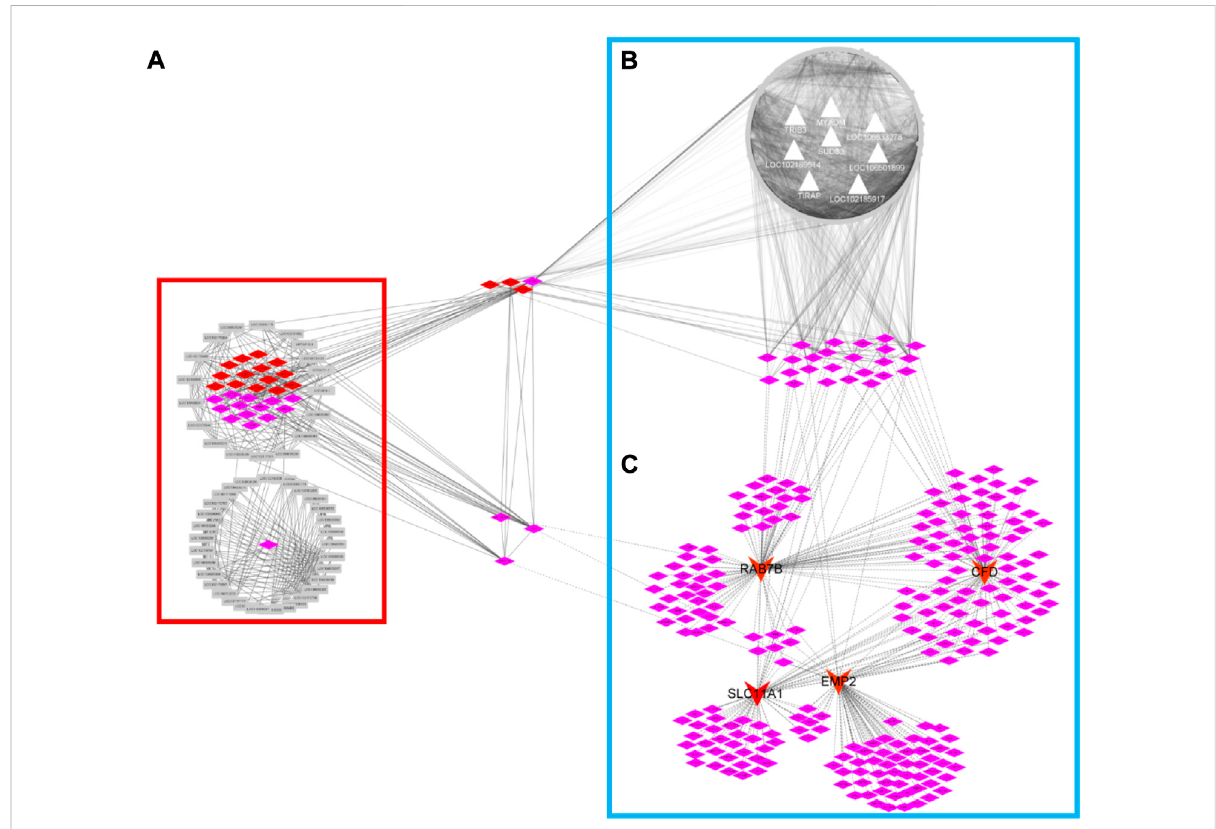
FIGURE 7 Co-expression regulatory network of high-sulfur protein gene, transcription factor, melatonin-dependent network and TIRB3-gene network. The red diamond node represents transcription factor, the pink node represents transcription factor cofactor. Gray node represents high sulfur protein gene in network (A) . The gray triangular node represents biomarker gene analysis by random forest machine learning approach in network (B) . The red arrow node represents biomarker gene of immune-related